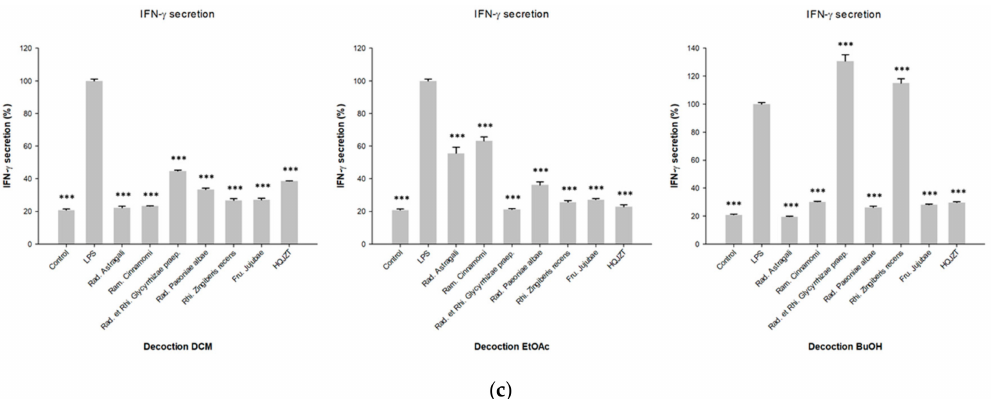
Figure 2. Inhibitory e ff ects of the fractions of the decoctions of HOJZT and its herbal components on